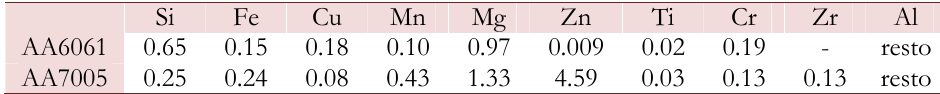
Tabella I: Composizione chimica nominale (% in peso) delle matrici in lega AA6061 e AA7005 dei compositi W6A20A